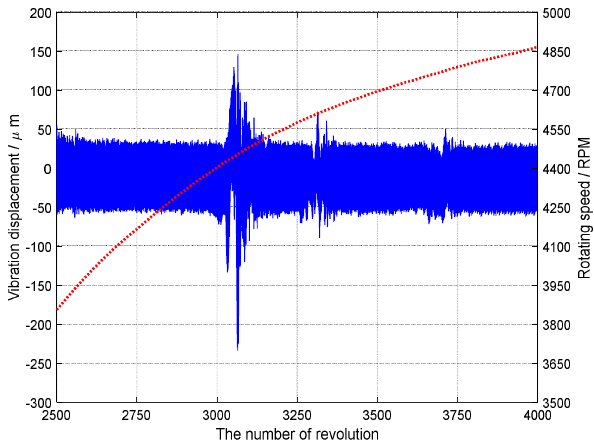
Figure 19. The angularly sampled vibration displacement and the rotating speed of the 24th blade.